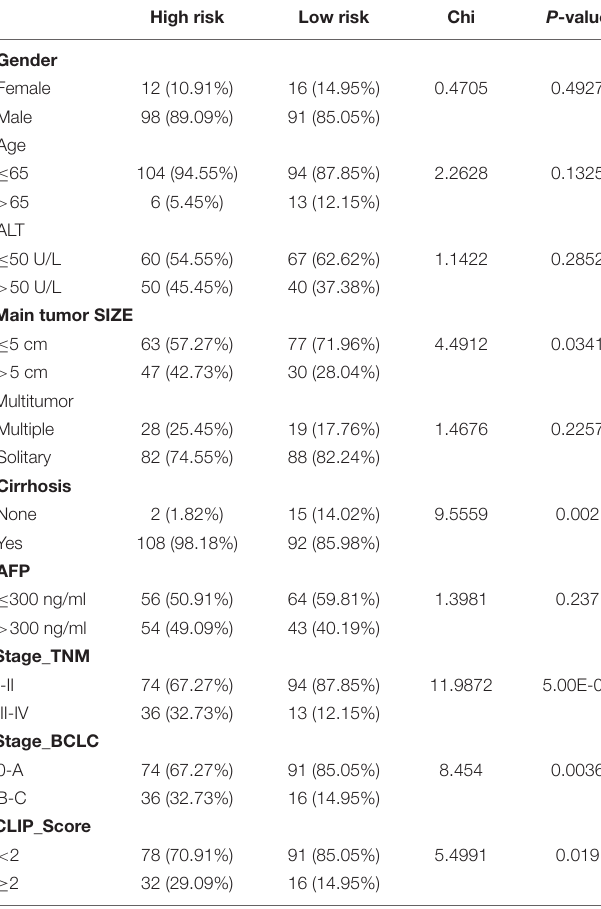
TABLE 1 | The chi-square test of the relation between different risk groups and clinical features in TCGA cohort.